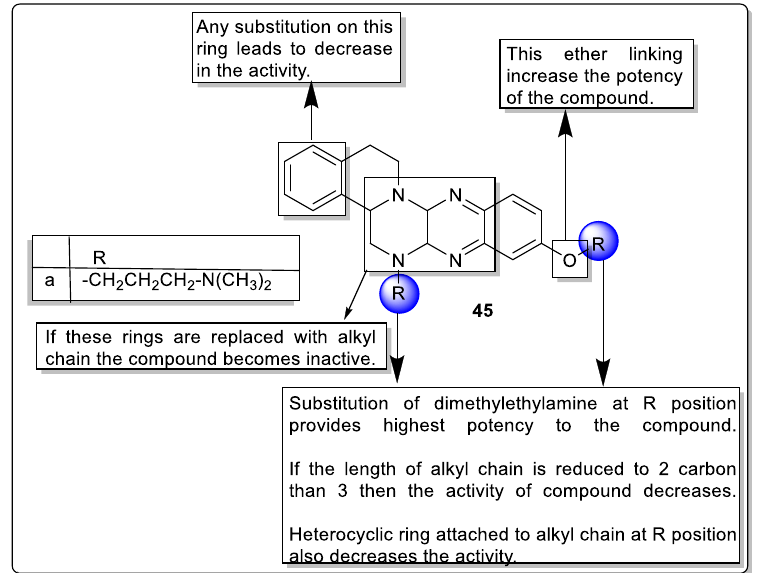
Figure 49. Structural activity relationship of isoquinoline hybrids ( 45 ) as potent PPAR ligands.